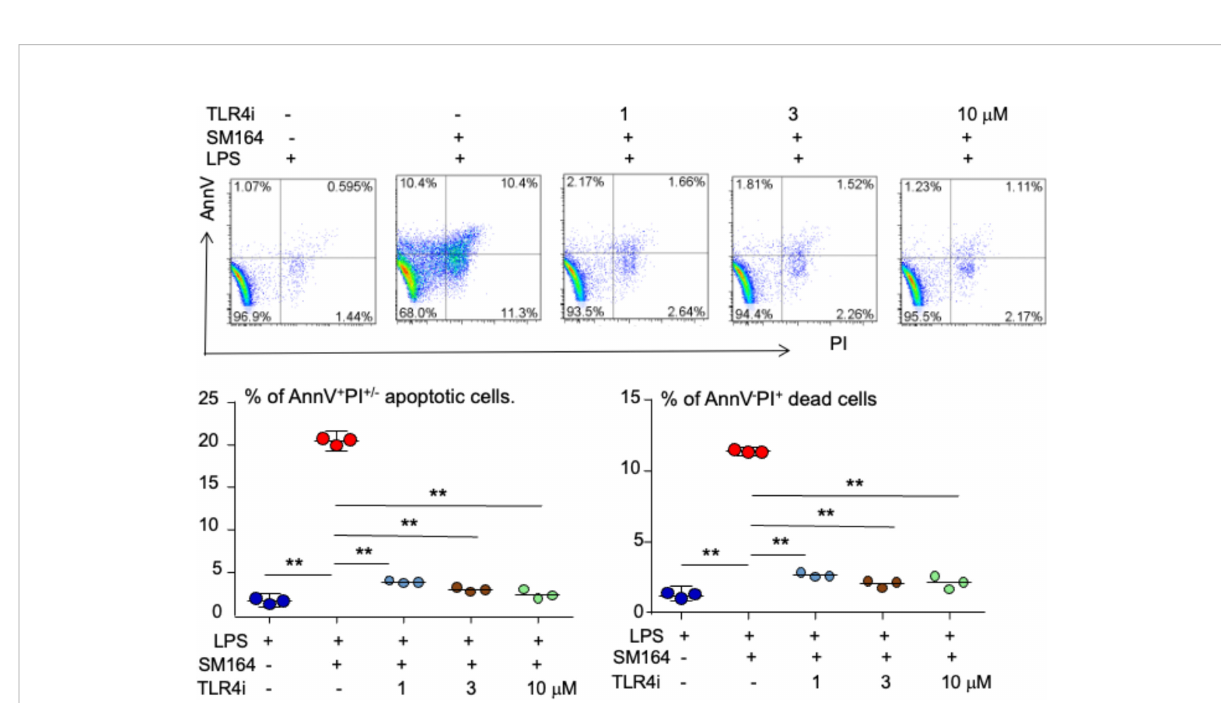
FIGURE 3 LPS triggers SM-164-induced apoptosis of MDA-MB-231 cells through TLR4. MDA-MB-231 cells were treated overnight with 100 ng/ml of LPS and SM-164 (SM) 3 nM, plus indicated dose of TLR4 inhibitor (TLR4i). AnnV + PI − /+ apoptotic cells were analyzed by fl ow cytometry. The data were from three repeat samples in one experiment. **p < 0.01 between the indicated groups. The experiments were repeated three times with similar results. LPS, lipopolysaccharide.